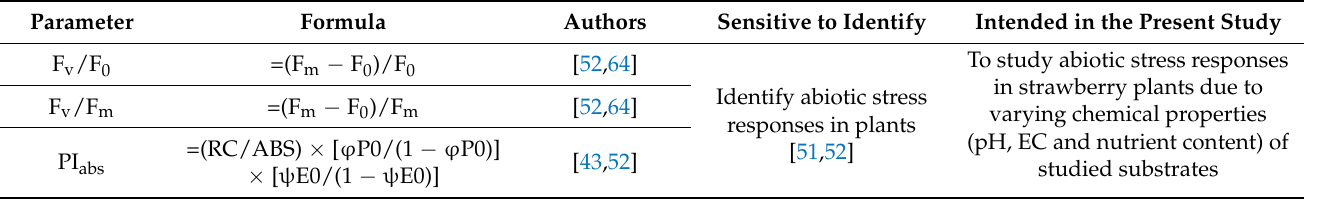
Table 3. Selected Performance Indices